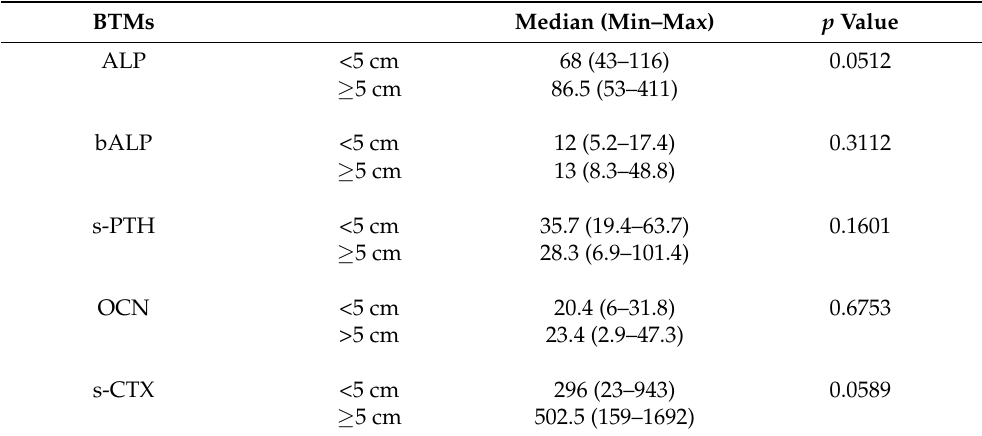
Table 2. Baseline Bone Tumor Markers (BTMs) and tumor size (>5 cm). ALP (alkaline phos- phatase); bALP (bone-alkaline phosphatase); s-PTH (parathyroid hormone); OCN (osteocalcin);